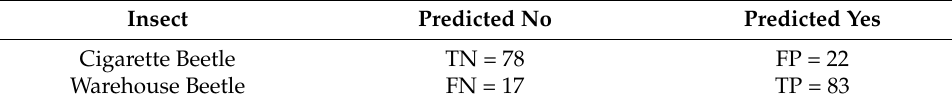
Table 3. Confusion matrix with values from test